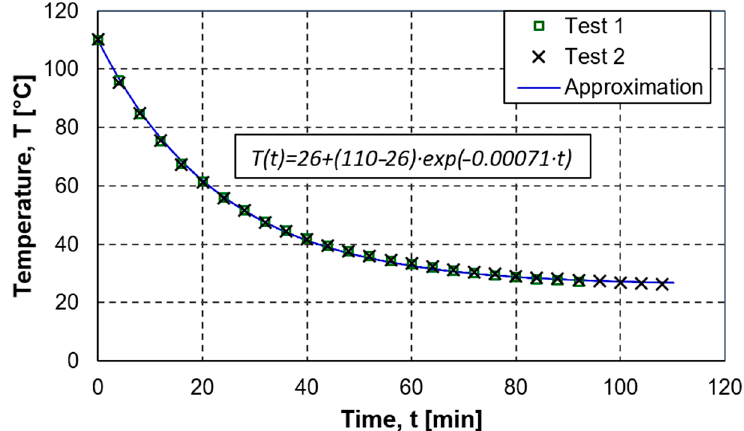
Figure 7. Shock absorber cooling curve.